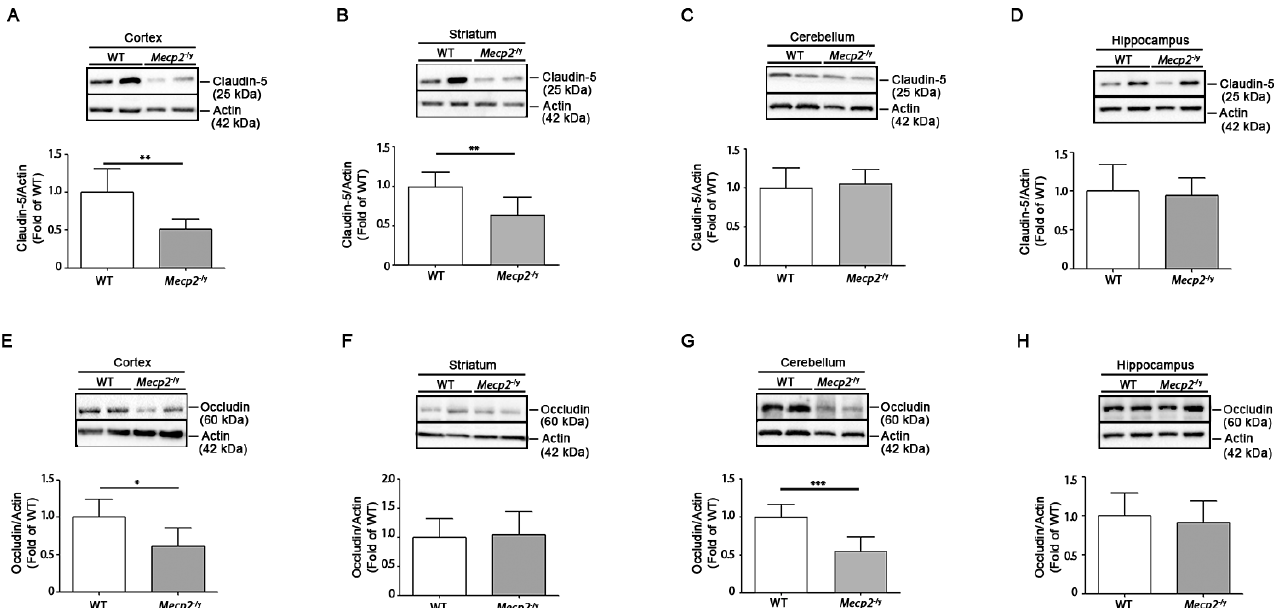
Figure 1. BBB disruption in Mecp2 -/y mouse model. Representative fluorescence micrographs ( A ) of brain cryosections from symptomatic Mecp2 -/y mice and age-matched WT littermates; semi-quanti- tative analysis ( B ) of FITC-albumin extravasation (bright green fluorescence) normalized on vessel marker laminin (red). Data are represented as mean ± SD from eight coronal sections from two dif- ferent mice. **, p < 0.01; (Mann–Whitney test). CTVF—corrected total vessel fluorescence.